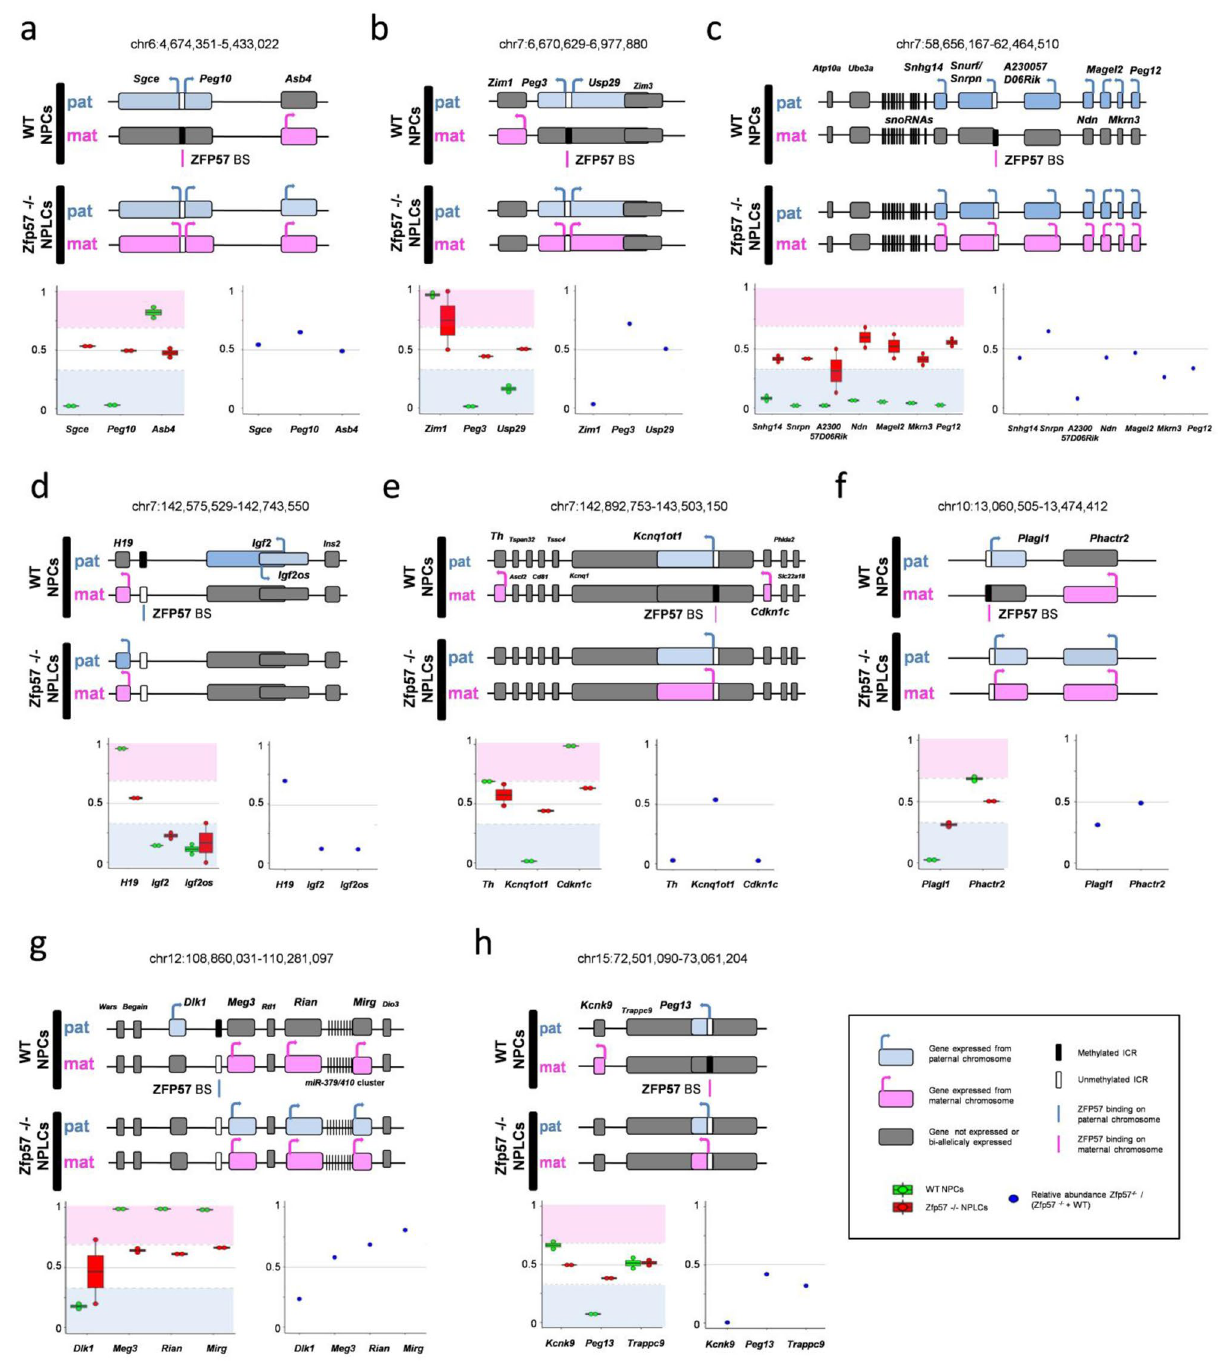
Figure 4. Coordinated change of allelic and levels of expression at imprinted gene clusters in the Zfp57 -/- day 12 cells. Panels ( a–h) represent 8 different imprinted gene domains. A schematic of the gene cluster with indication of the imprinting status in wild-type and Zfp57 -/- day 12-JB1 cells, and location of the ZFP57 binding site (ZFP57 BS) is shown at the top of each panel. In each panel, the box-plot in the lower left shows the allelic expression ratio of the genes of the domain in the wild type (green) and Zfp57 -/- (red) day 12-JB1 cells. The dot- plot in the lower right shows the bulk gene expression changes detected in Zfp57 -/- day 12-JB1 cells ( Zfp57 -/- day 12 / (wild-type day 12 + Zfp57 -/- day 12)). All values correspond to the average of two biological duplicates (for details, see Supplementary Tables 2, 4 and